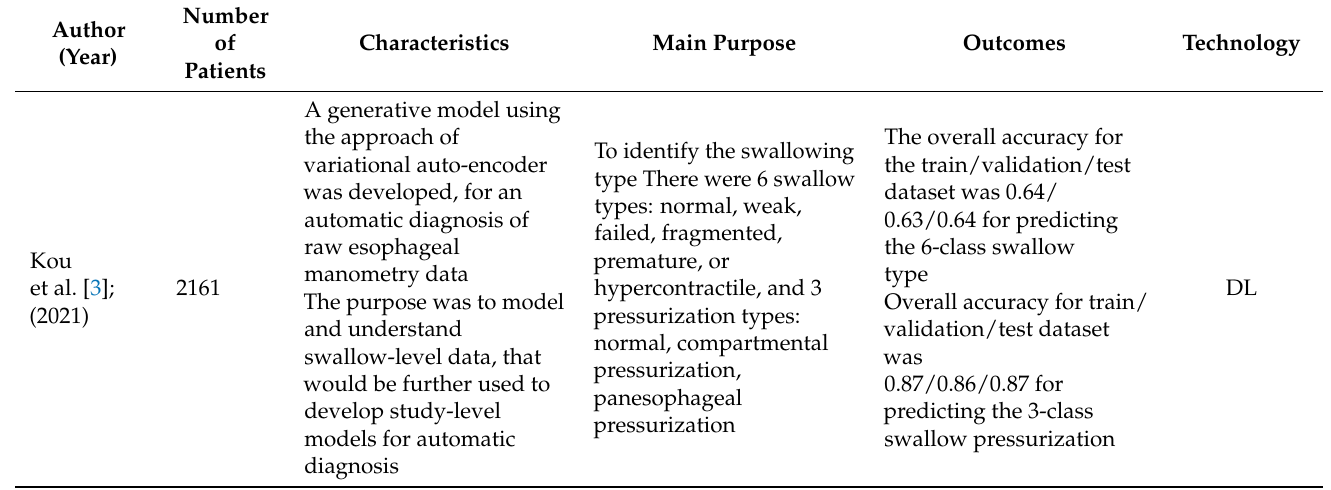
Table 1. Comparative results of previous